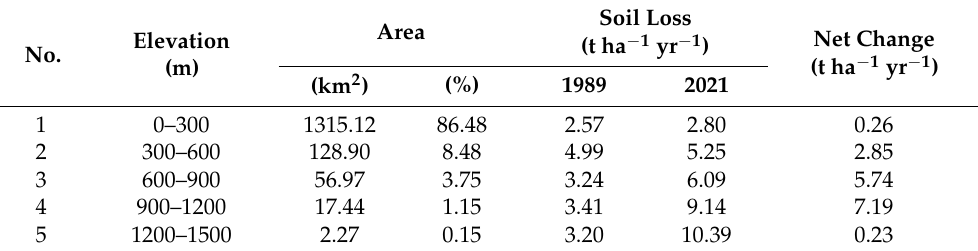
Table 13. Soil loss rates in elevation classes and net changes between 1989 and 2021.